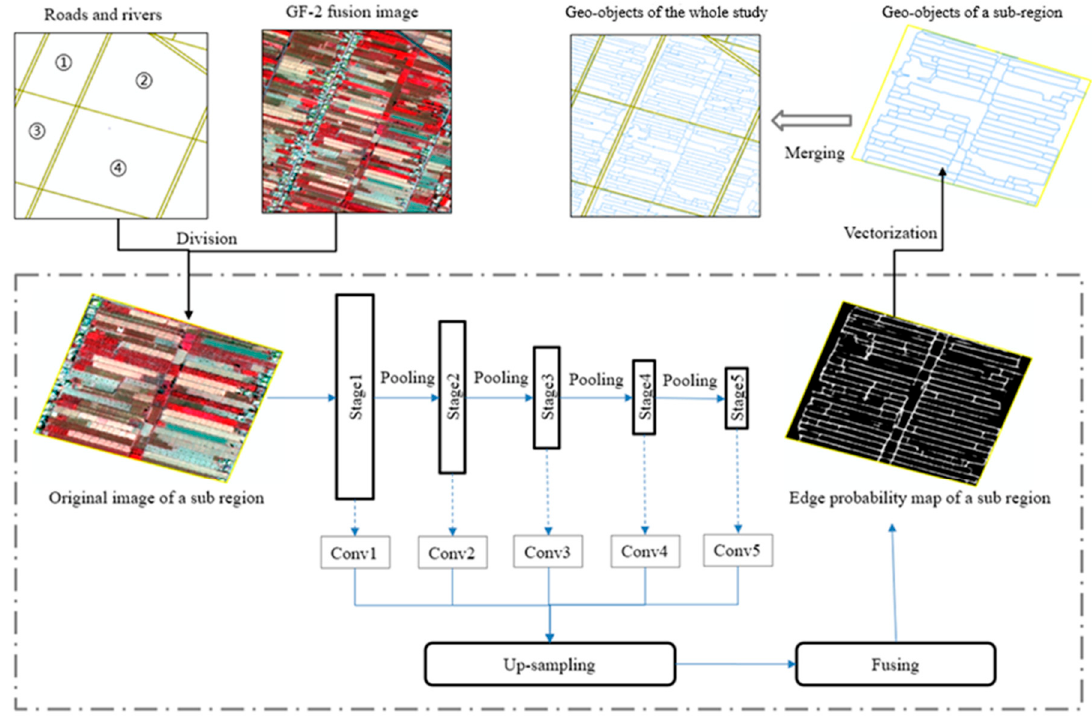
Figure 4. Flow chart of the convolutional neural network (CNN)-based geo-object extraction [37].